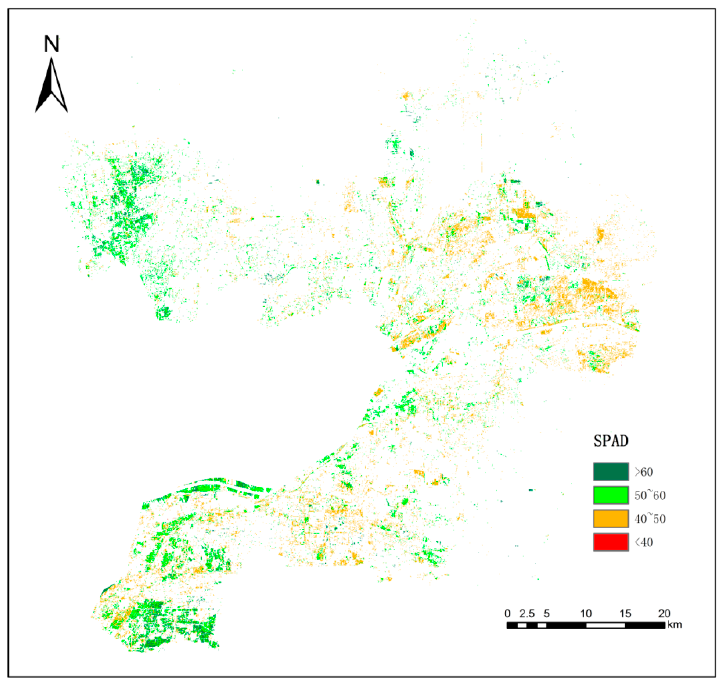
Figure 5. The spatial distribution map of the inverted SPAD values in the study area. Table 12. The results of the inverted SPAD values in the study area.